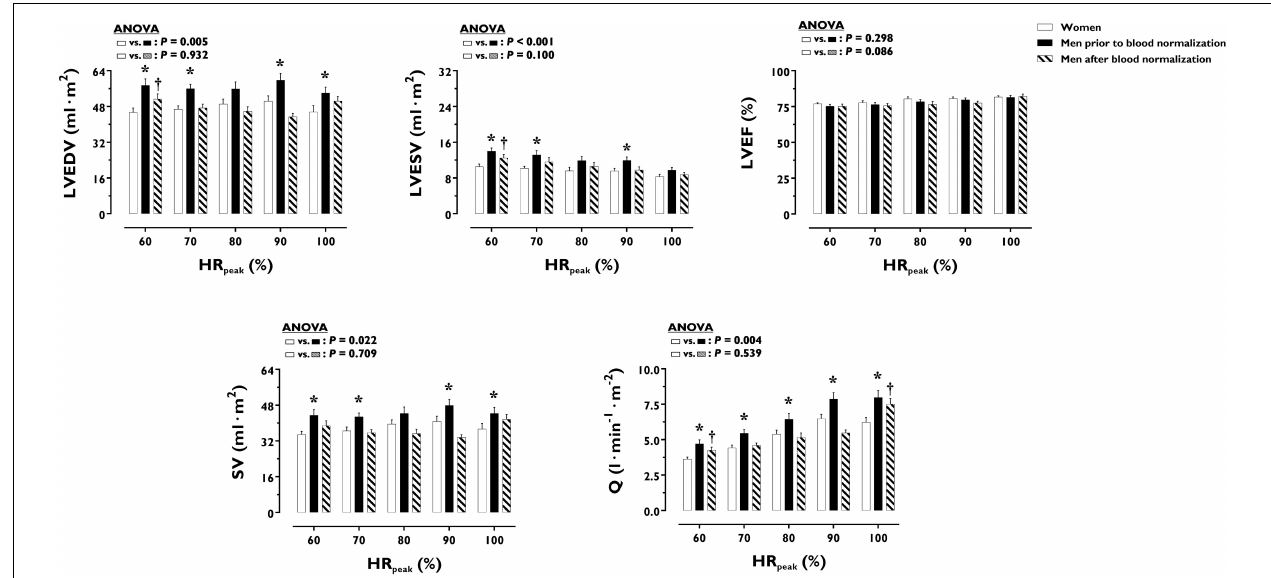
FIGURE 1 | Left ventricular volumes and function during incremental exercise in women and men prior to and after blood normalization. * P < 0.05 between women and men prior to blood normalization. † P < 0.05 between women and men after blood normalization. Data are expressed as mean ± SEM. Number of biological observations for each graph: LVEDV ( n = 195), LVESV ( n = 195), LVEF ( n = 195), SV ( n = 195), Q ( n = 195). Echocardiographic data were analyzed within ± 5 bmp of specific percentages of HR